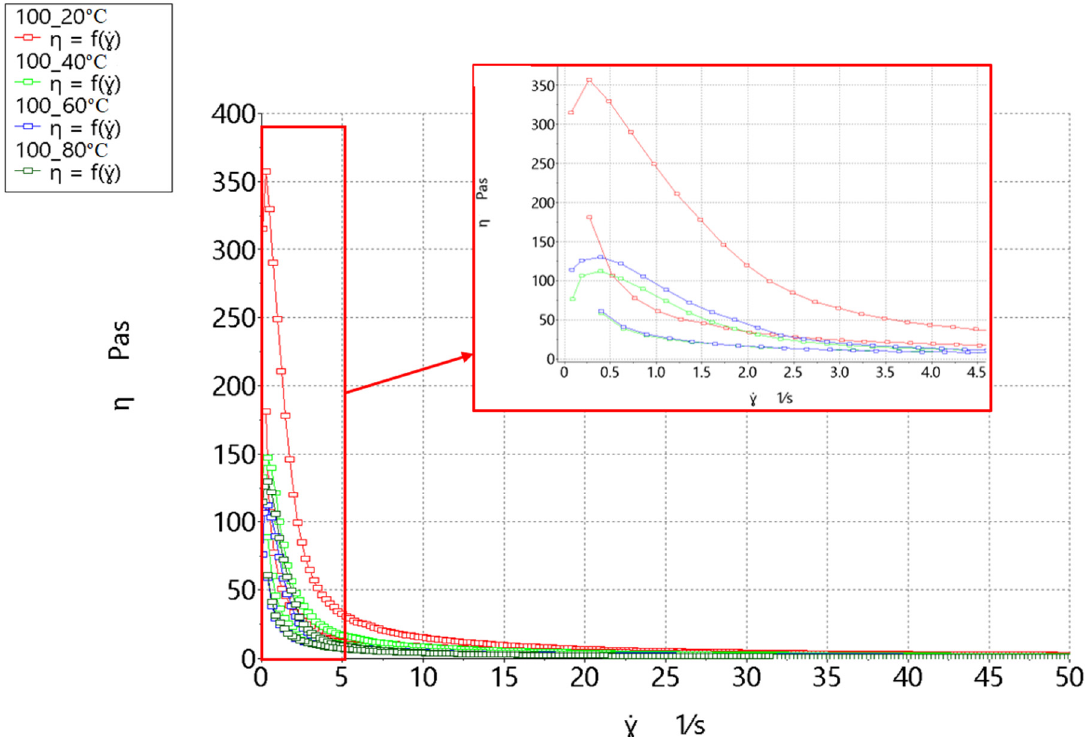
Figure 5. Viscosity and thixotropy of hot trub precipitated from 100% Pilsner malt boiled for 60 min and collected from the industrial brewery at 15 °C, 40 °C, 60 °C, and 80 °C.